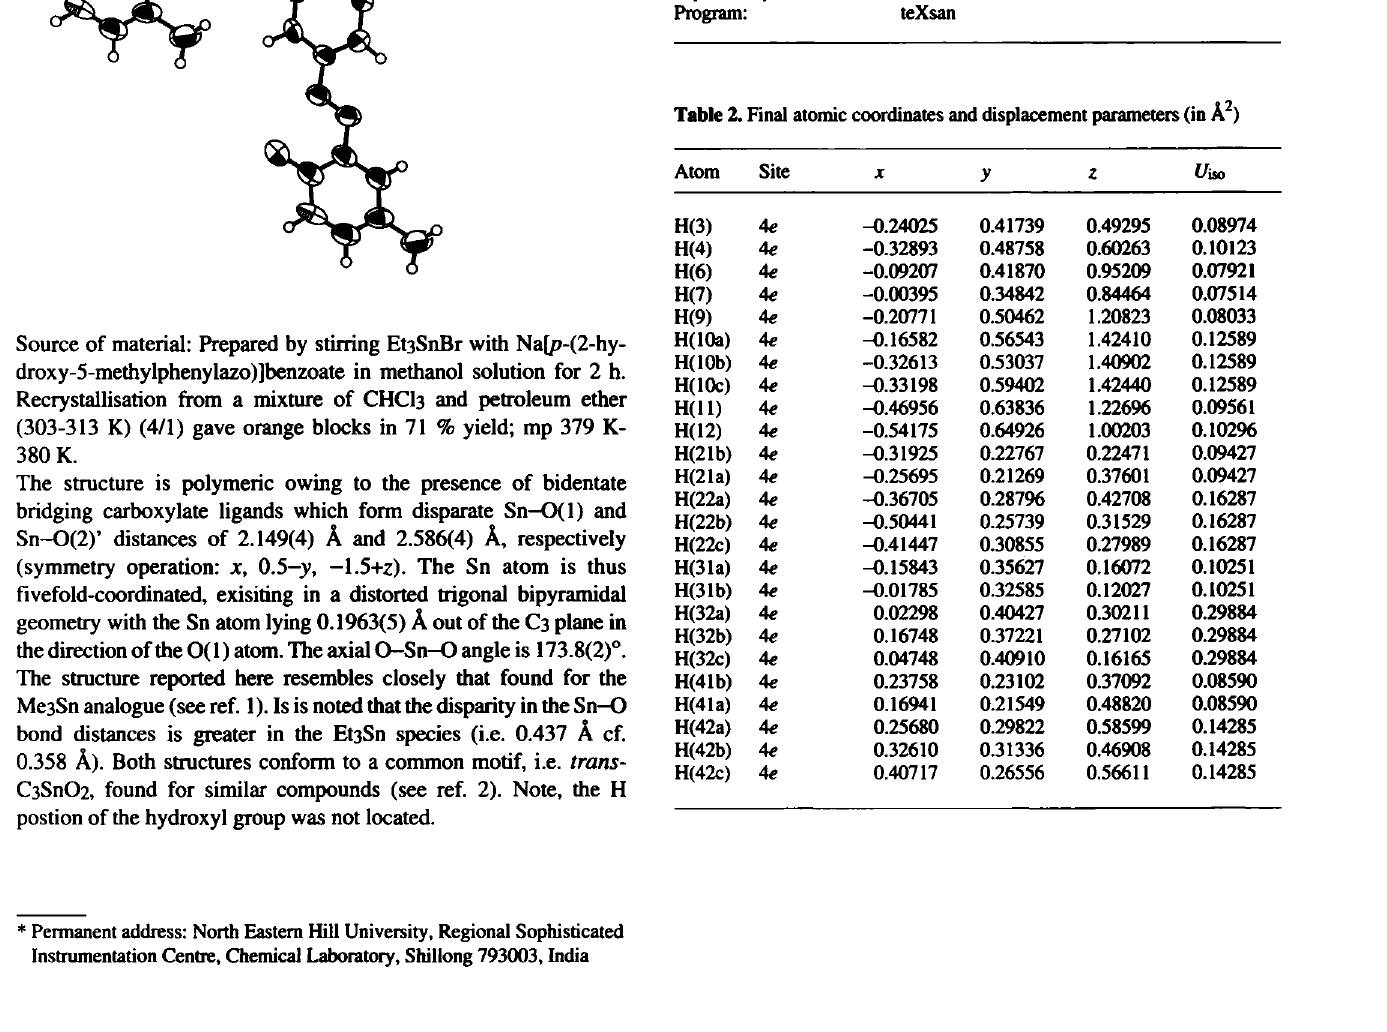
Table 1. Parameters used for the X-ray data collection Crystal: